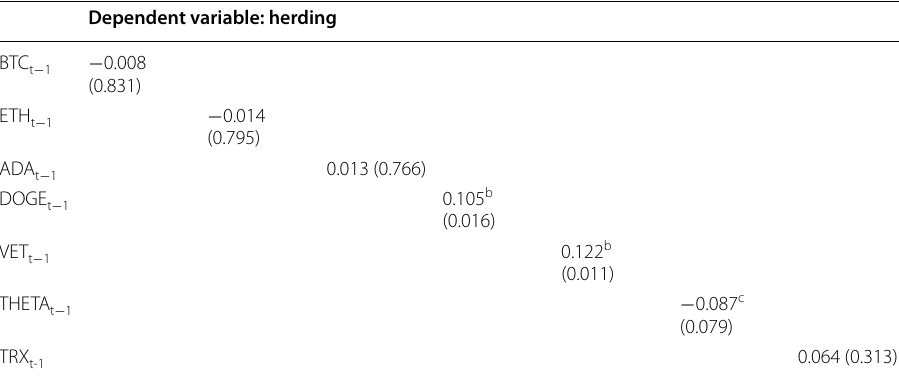
Table 7 Reverse relationship between Herding and